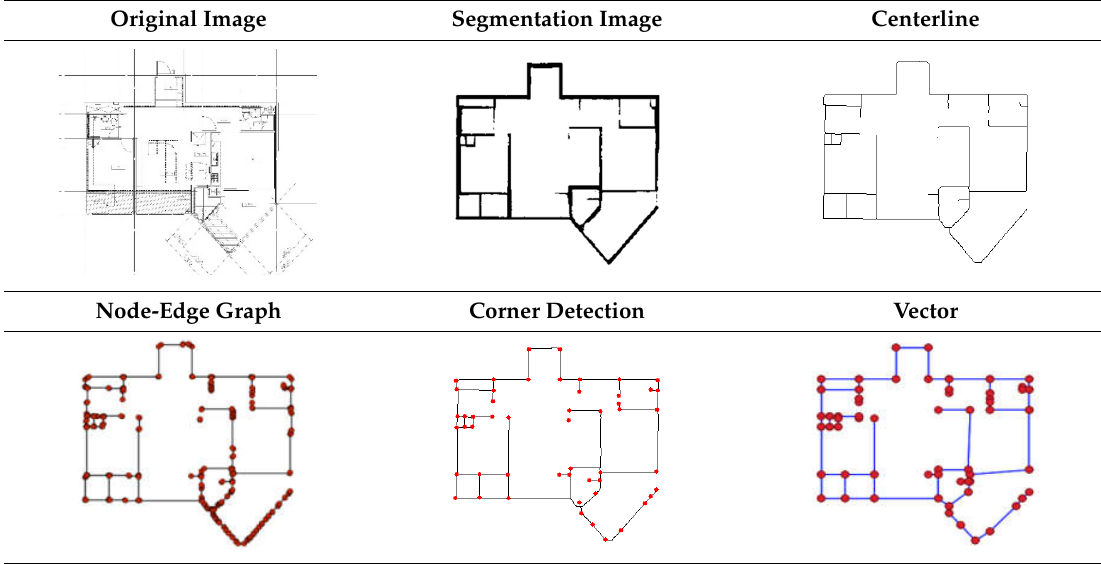
Table 7. Intermediate products and input / output of the process.